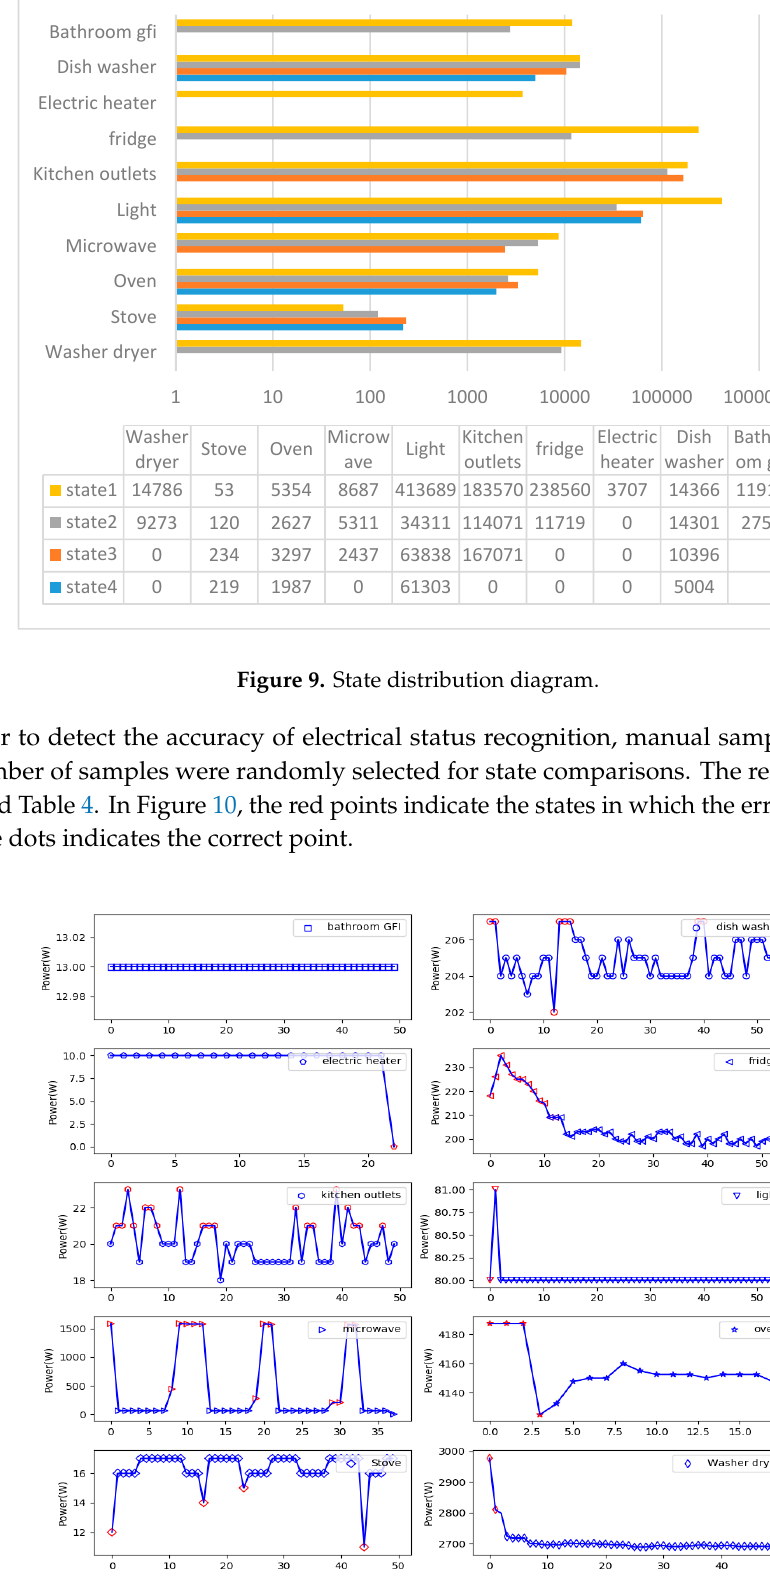
Figure 10. Identification result graphs.